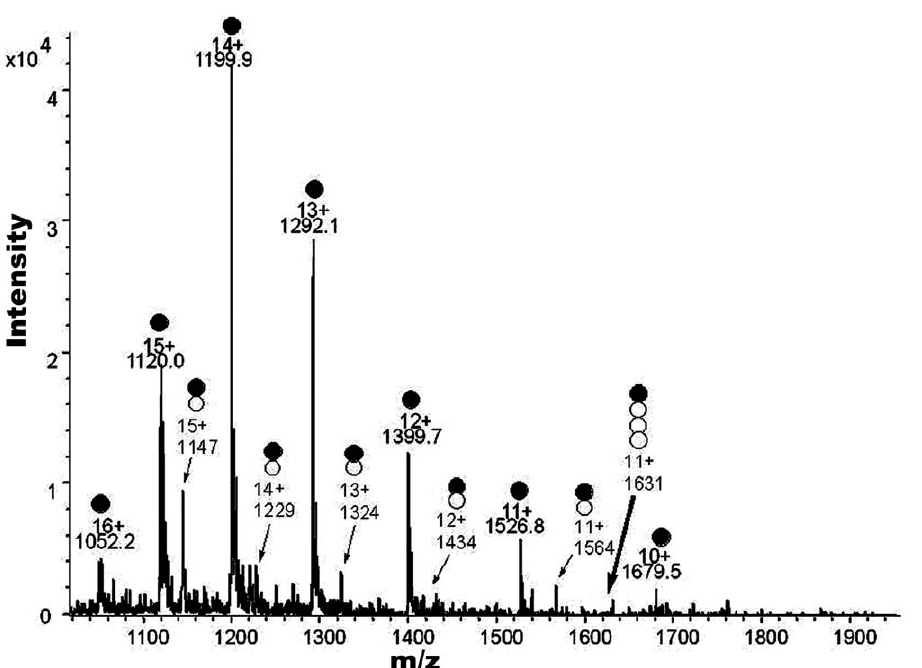
N N # multiply-charged ion peaks of CaM-Ca 2 + -FP complex. Multiply-charged ion peaks of CaM-Ca 2 + ;